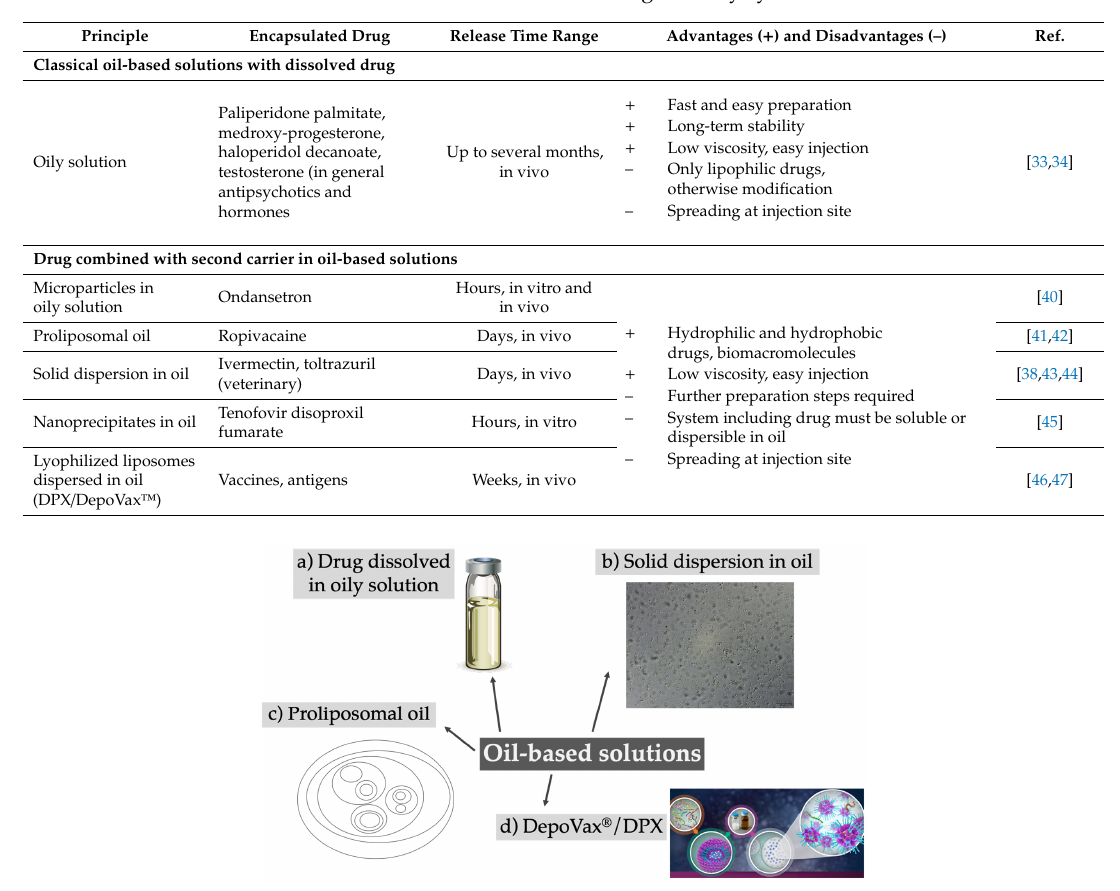
Figure 2. Overview of different approaches using oil-based solutions as depot formulations, ranging from the classical dissolved drugs in oil ( a ) to more advanced systems like solid dispersions ( b ), proliposomes ( c ), or the DepoVax / DPX system ( d ). ( a ) Adapted from [37]; ( b ) Reprinted from [38], with permission from Elsevier; ( d ) Adapted from [39]. Table 2. Overview of oil-based drug delivery systems.